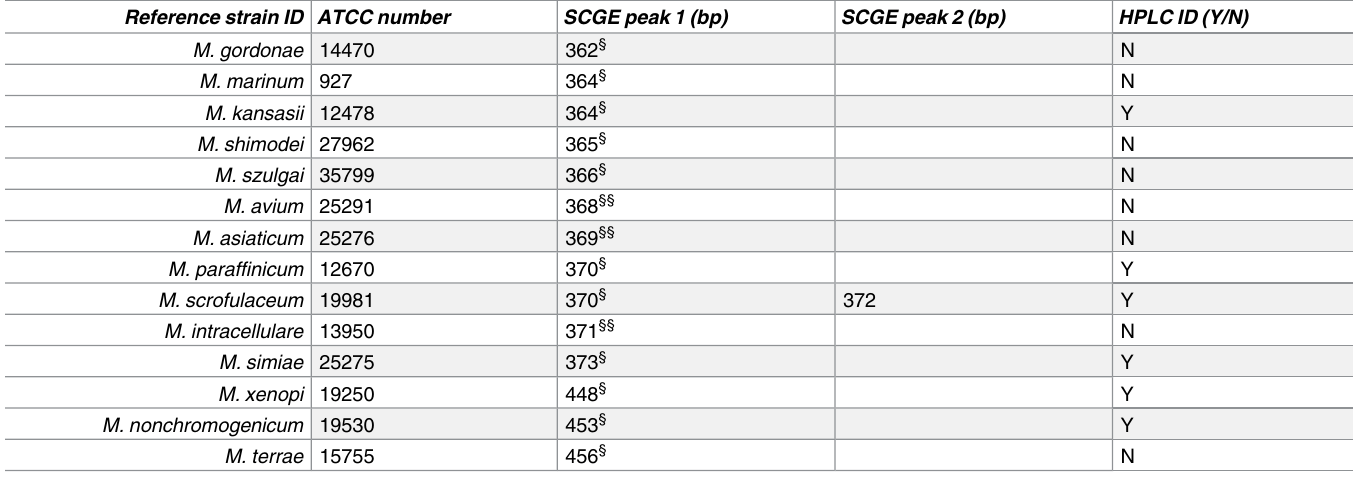
Table 1. Sequencer capillary gel electrophoresis derived internal transcribed spacer-amplified fragment lengths (or peaks) of American Type Culture Collection reference strains of slowly growing nontuberculous mycobacteria. Reference strain ID ATCC number